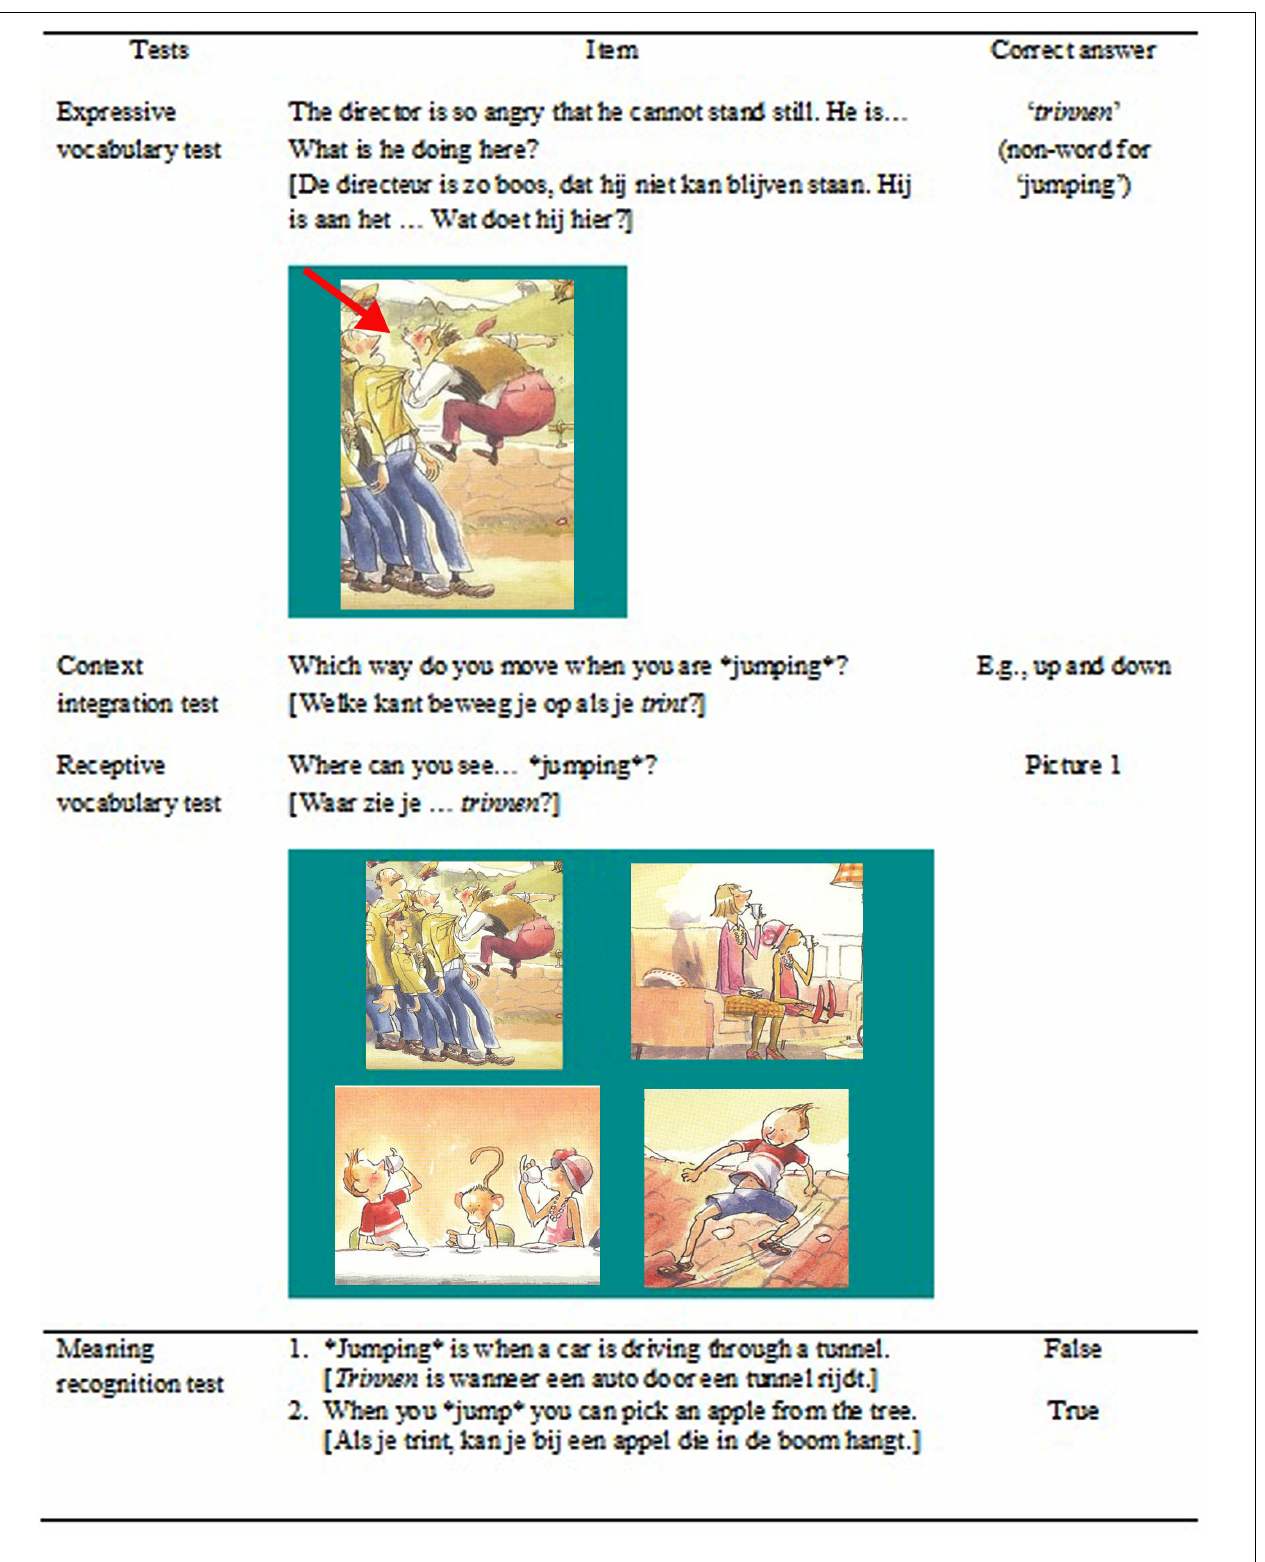
Frontiers in Psychology |